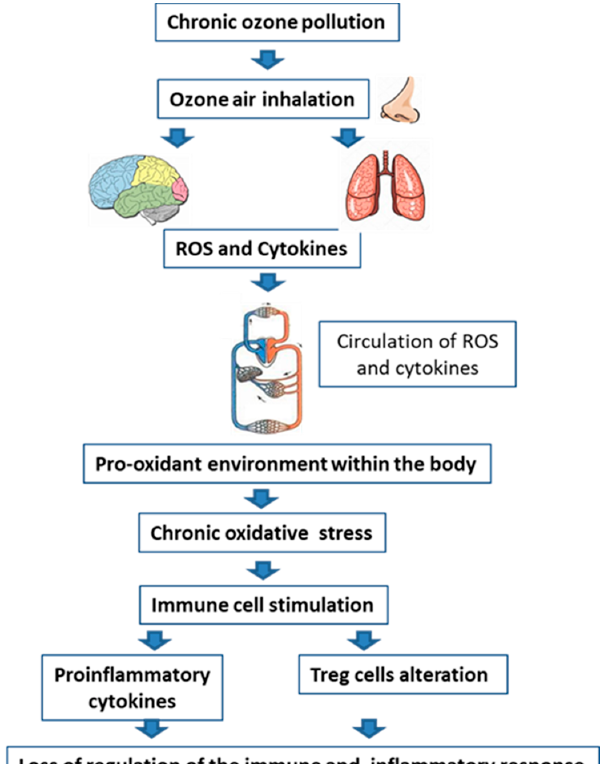
Figure 1. The effect of environmental pollution by ozone on the loss of regulation of the Inflammatory response. Chronic exposure to environmental pollution by ozone reaches the brain and lungs, causing an increase in the formation of ROS secondary to exposure to this gas. This induces an increase in prooxidants and cytokines, which leads to an increase in proinflammatory cytokines, causing a loss of regulation of the immune response in the body.